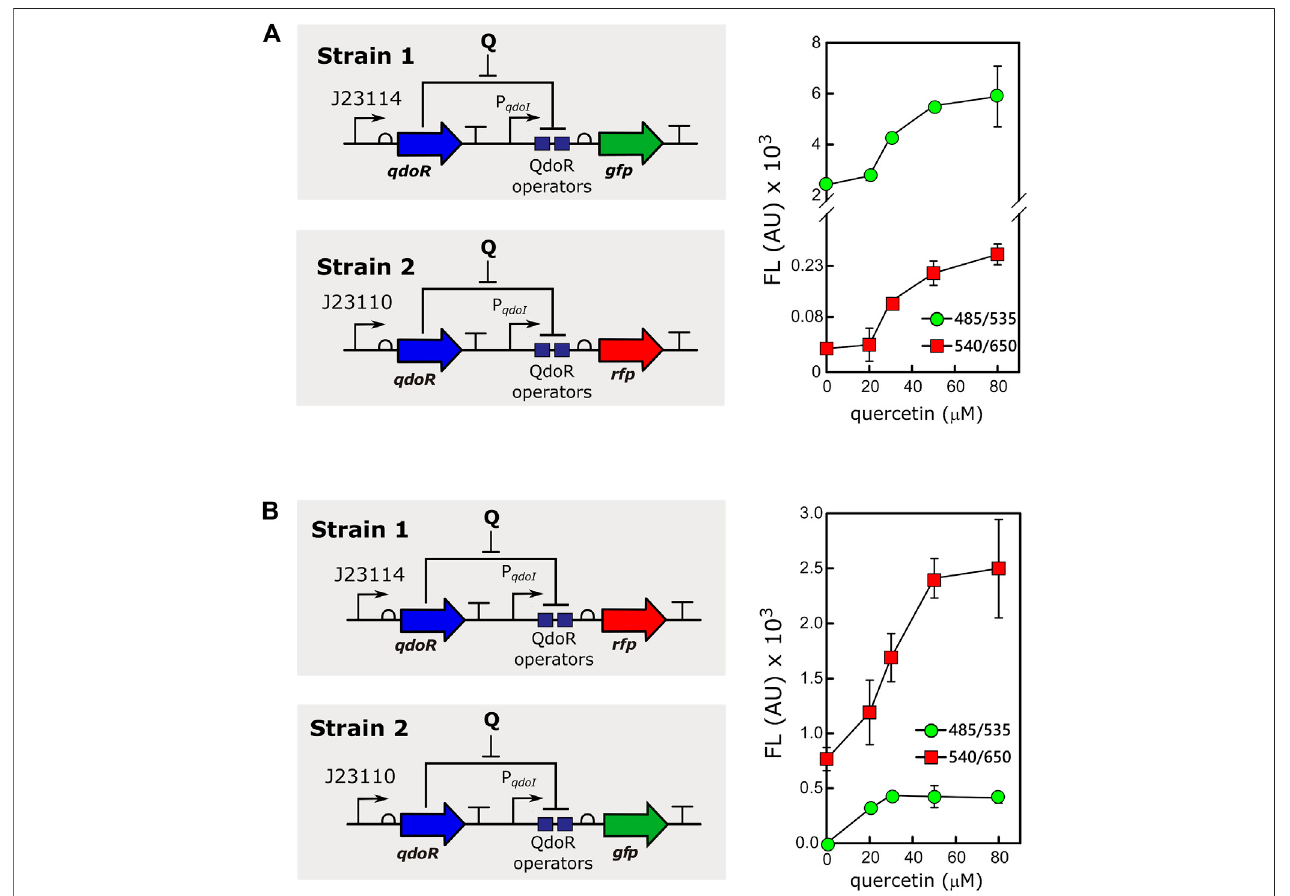
FIGURE 4 | The sameinducer concentration givesdifferentoutputsina mixedculture of E.coli strains. (A) Strain1, E.coli MG1655 carrying thecircuitJ23114- qdoR - P qdoI - gfp was mixed with strain 2, E. coli MG1655 with J23110- qdoR -P qdoI - rfp , keeping an equal proportion of both strains. The mixed culture was induced with different concentrations of quercetin, and fl uorescence (FL) was measured using the following combinations of emission ( λ em ) and excitation ( λ ex ) wavelengths: 485 nm ( λ ex ) and 535 nm( λ em )forgreen fl uorescencemeasurementsand540 nm( λ ex )and650 nm( λ em )forred fl uorescencemeasurements.NotethatthegraphinAhasabreakinthe y -axistoshowthedataplottedforstrain2. (B) Toruleoutanyeffectofthereporteritselfontheresults,wemeasuredtheoutputsasinA,butwiththefollowingcon fi